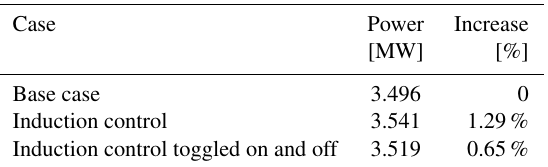
Table 2. Mean power values from Fig.